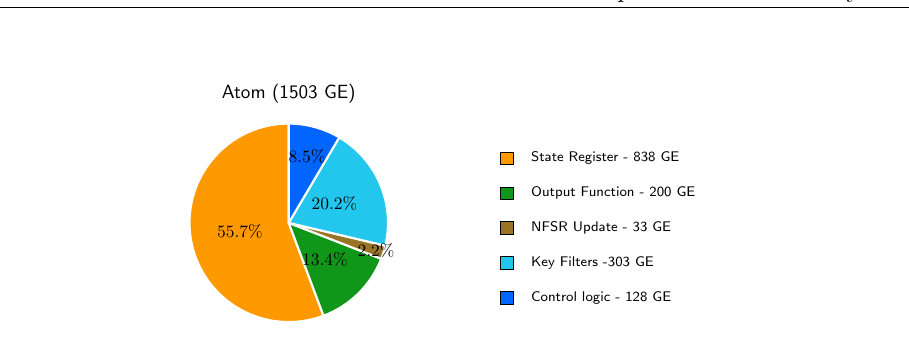
Figure 4: Breakdown of the area of individual components for the STM 90 nm process using the compile_ultra -no_autoungroup synthesis